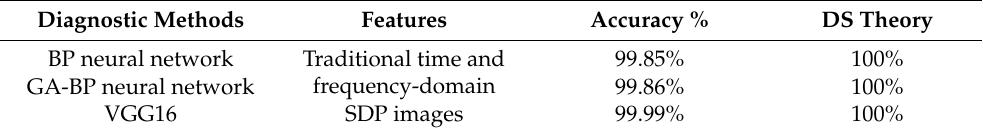
Table 6. Comparison of VGG16 with the BP and GA-BP algorithms. Diagnostic